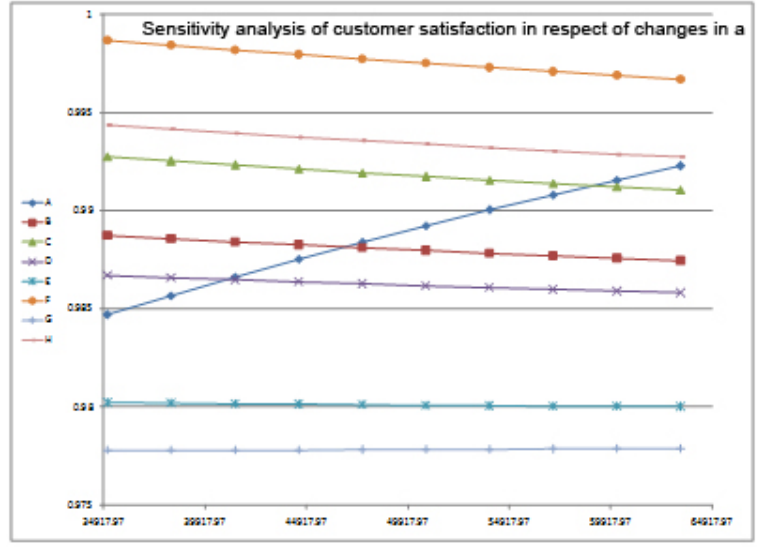
Fig.1. Change in customer satisfaction toward change in market basis for manufacturer A in Nash